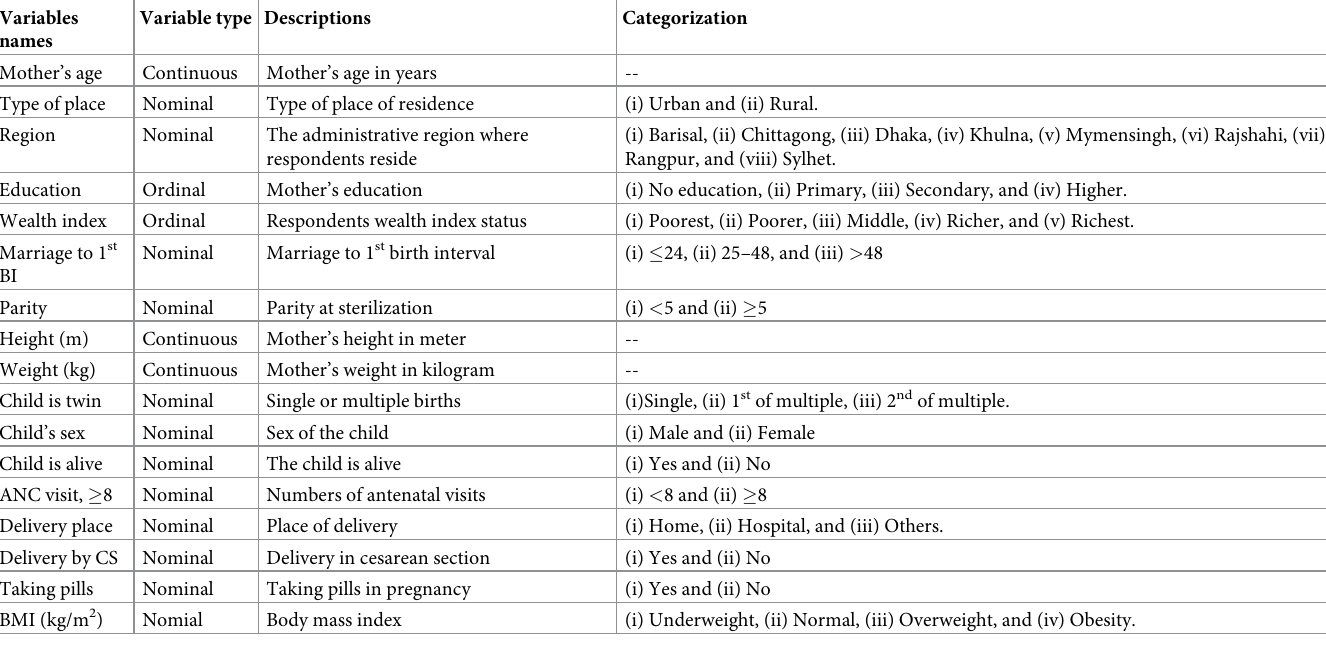
Table 1. Predictor names, predictor types, predictor descriptions, along with their